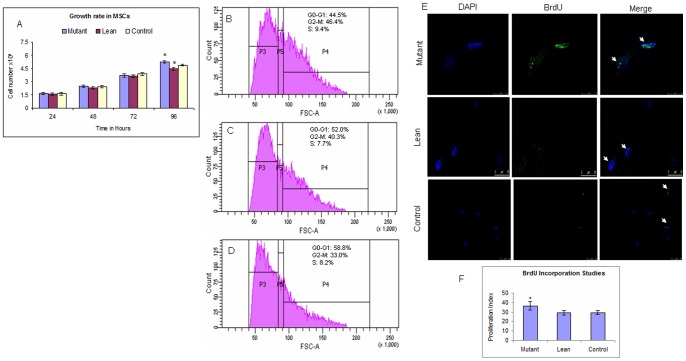
Population doubling assay and Cell cycle analysis of BM-MSCs.(A) MSCs from Mutant, Lean and Control, were measured for proliferation rate at 24, 48, 72 and 96 hrs. BM-MSCs from Mutants showed an increase in proliferation at all the time points and at 96 hours, the PDA was significantly higher compared to Lean and Control. Values represent the absolute cell count and have been computed from three independent experiments performed in duplicates (Mean ± SE, n = 6) (B) Cell cycle analysis of BM-MSCs from Mutants showing an increase in ‘S’ phase and G2-M as compared to Lean (C) and Control (D). Values have been represented as Mean ± SE (n = 6) from three individual experiments performed in duplicates. (E) Cell cycle analysis of BM-MSCs showing an increase in BrdU incorporation (‘S’ phase) (green) from Mutant compared to Lean and Control and proliferation index (F). Values have been represented as Mean ± SE (n = 6) from three individual experiments performed in duplicates. Asteric (*) indicates p<0.05 using ANOVA.